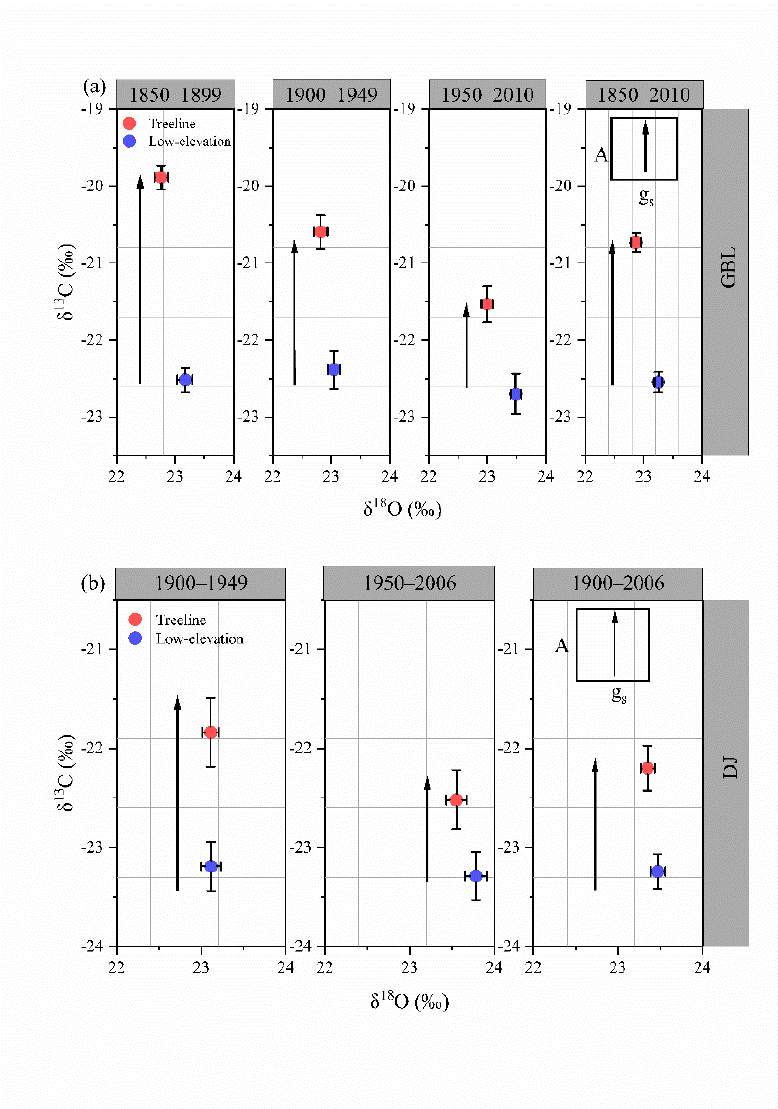
Figure 5. Relationships between δ 13 C and δ 18 O in treelines vs. low elevations in two species at GBL ( a ) and DJ ( b ) transect. Mean values (symbols) ± 1 SE are shown. Shifts in the isotopic space are represented by arrows. The insets display the relative changes in the corresponding photosynthetic assimilation rate ( A ) vs. stomatal conductance ( g s ) responses, according to the dual-isotope conceptual model. Note that the upward vertical arrows show the increase in the δ 13 C from low elevation to treeline over equal or similar δ 18 O values, which is a typical scenario of constant stomatal conductance and increasing photosynthesis in the carbon and oxygen double-isotope model [37] .